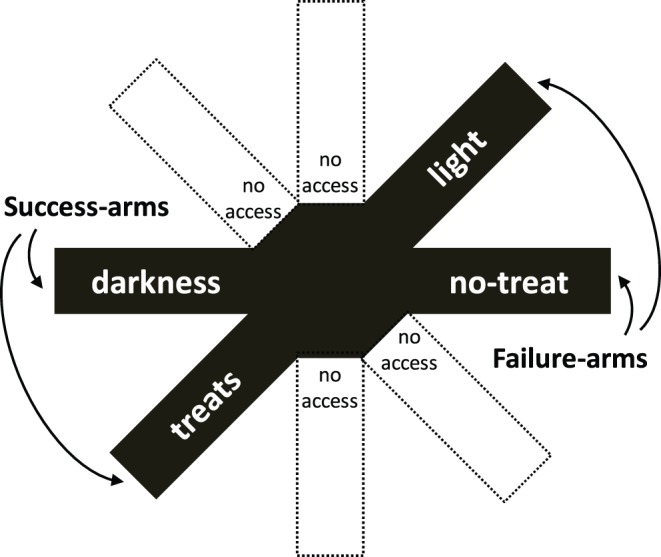
The automated-maze.In this study, four arms of an 8-arm radial arm maze were accessible. Reaching the end of two arms activated successful outcomes: treats (promotion success, i.e., gains) and darkness (prevention success, i.e., safety). Reaching the end of the other two arms activated failure outcomes: no-treats (promotion failure) and lights-on (prevention failure).